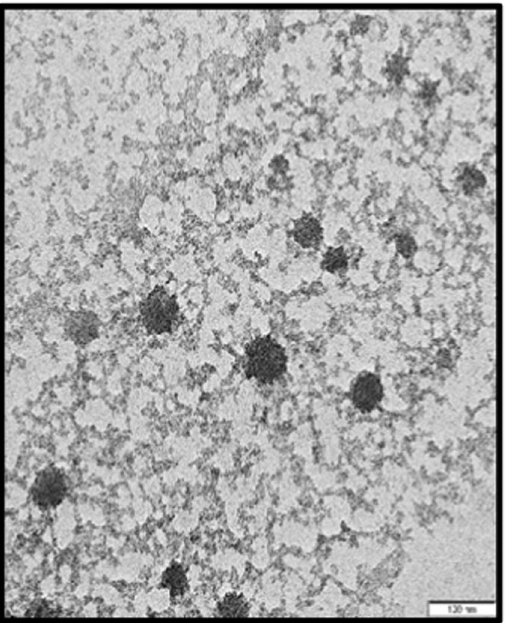
Figure 1. TEM images of the nanoparticles morphology and average size of